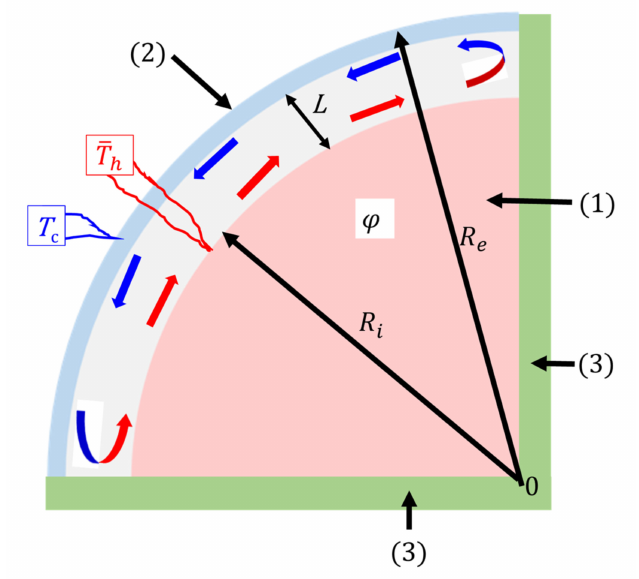
Figure 1. Scheme of the considered